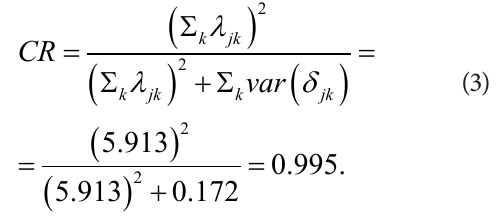
Table 3. Validity of loading factor and significance of transformational leadership Factors Estimate alpha